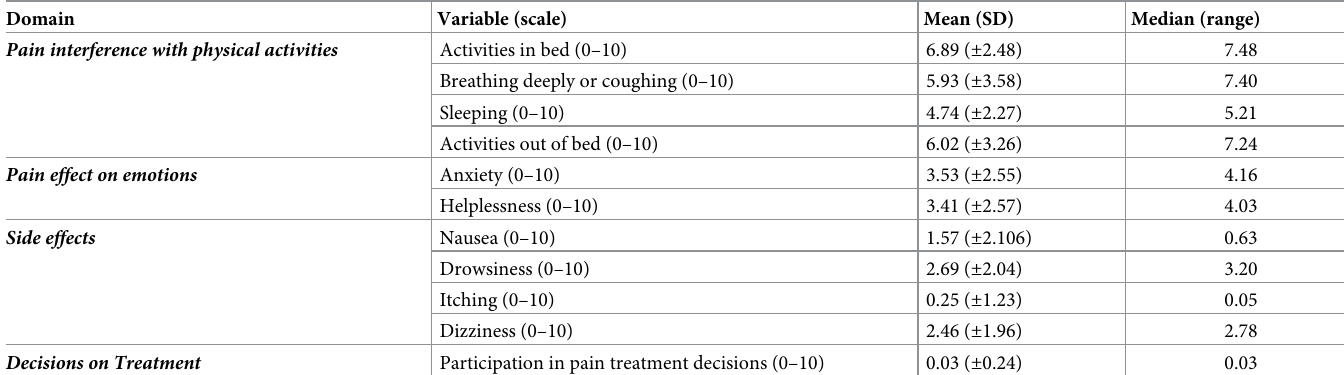
Table 2. Postoperative pain characteristics and management (n = 138).